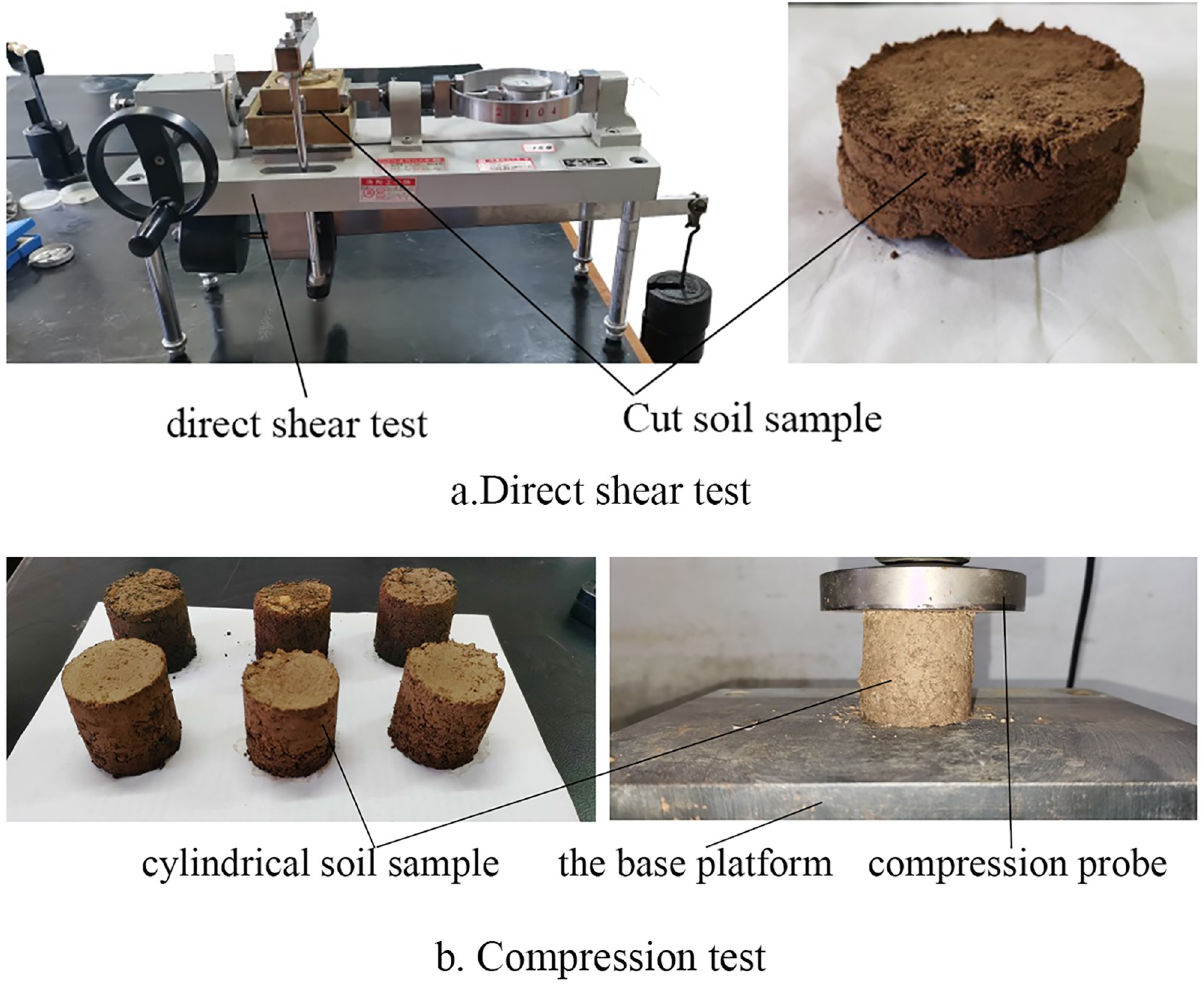
Fig 2. Soil parameter